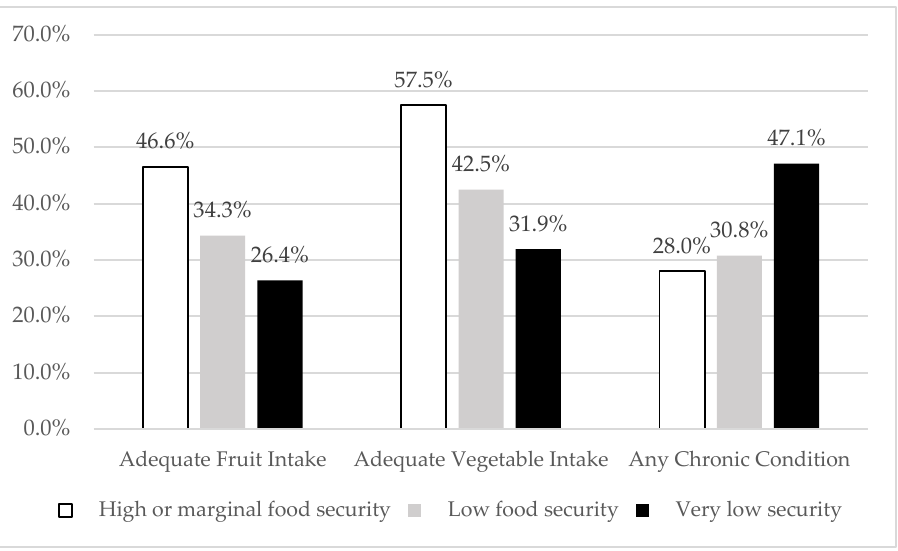
Figure 2. Adequate fruit and vegetable intake and any chronic condition by food security status among participants who attended free food and produce distribution events in Los Angeles County, California, 2021.